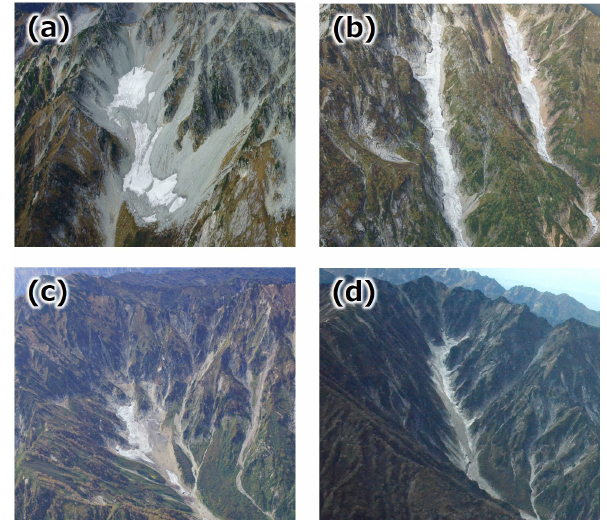
Figure 2. The five very small glaciers (VSGs) in this study at the end of snowmelt season in 2016. (a) Gozenzawa. (b) Sannomado (left) and Komado (right). (c) Kakunezato. (d) Karamatsuzawa. All taken on 30